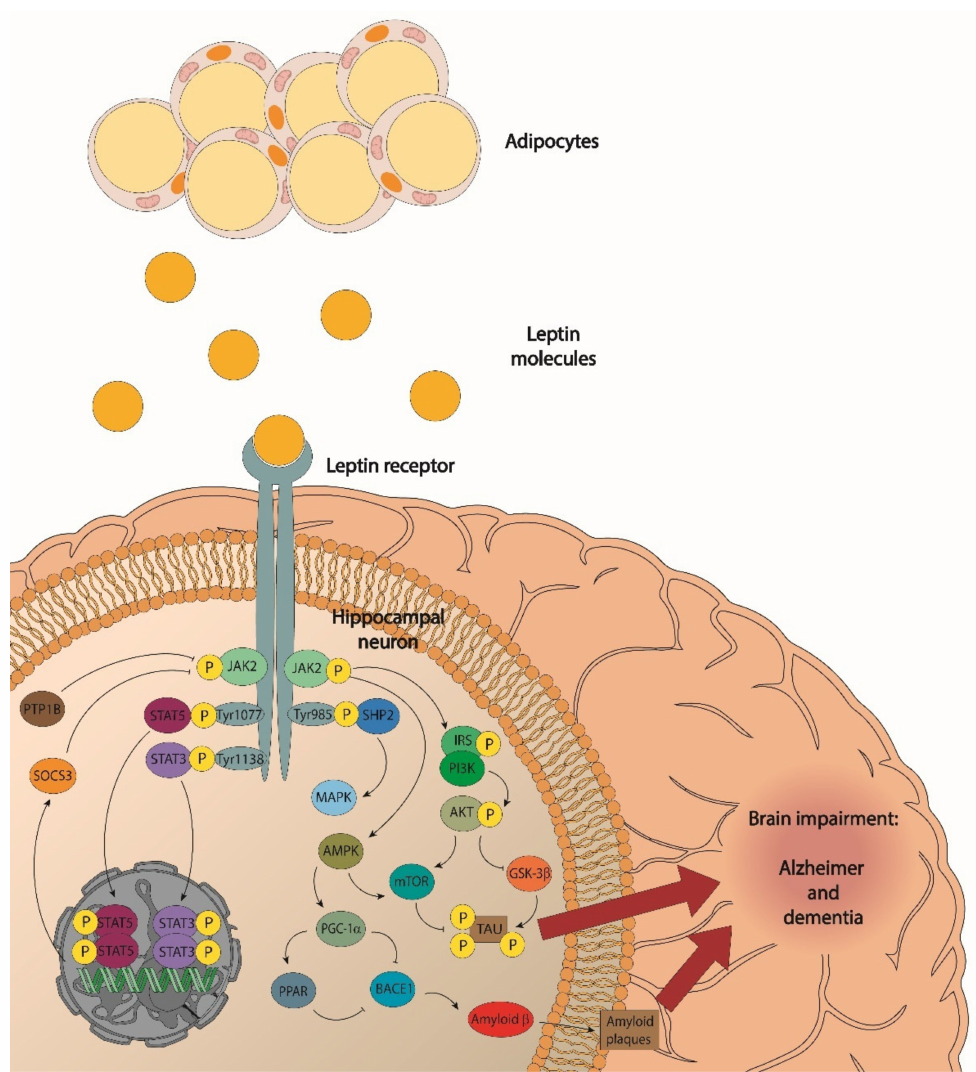
Figure 1. Leptin signalling in a hippocampal neuron. Leptin, mainly released by adipose tissue, reaches a hippocampal neuron where, binding to LepRb, activates the JAK/STAT, PI3K/Akt, and AMPK signalling pathways. PI3K/Akt pathway activation leads to mTOR activation, influencing synthesis and aggregation of Tau, as well as GSK-3 β inactivation, which, in turn, is not able to hyperphosphorylate Tau. AMPK pathway activation leads to PGC-1 α and PPAR activation, which, translocated to the nucleus, inhibit BACE1 transcription and decrease A β production. SOCS3 and PTP1B are negative regulators of leptin signalling acting on JAK2 and, therefore, generate leptin resistance that may cause the worsening of